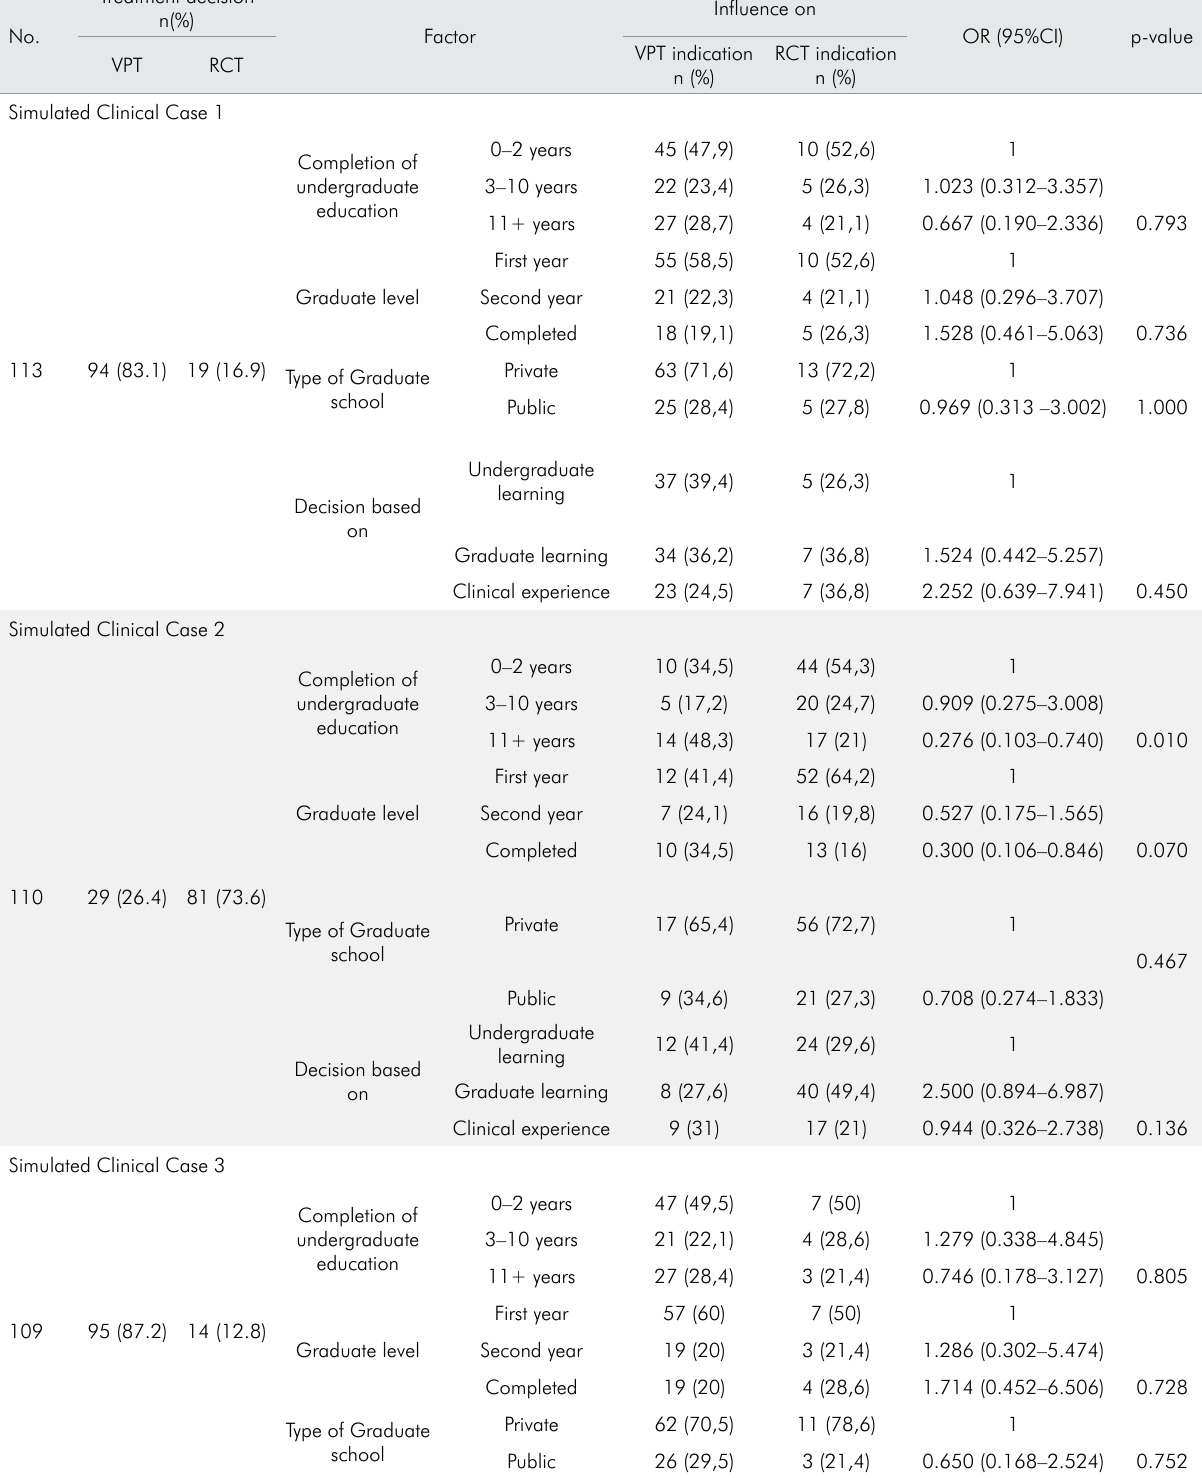
Table 2. Participant’s profile: Bivariate logistic regression model showing significant predictors (p < 0.05), odds ratio (OR), and 95% confidence interval (95%CI) for the preference of root canal treatment (RCT) over vital pulp therapy (VPT).